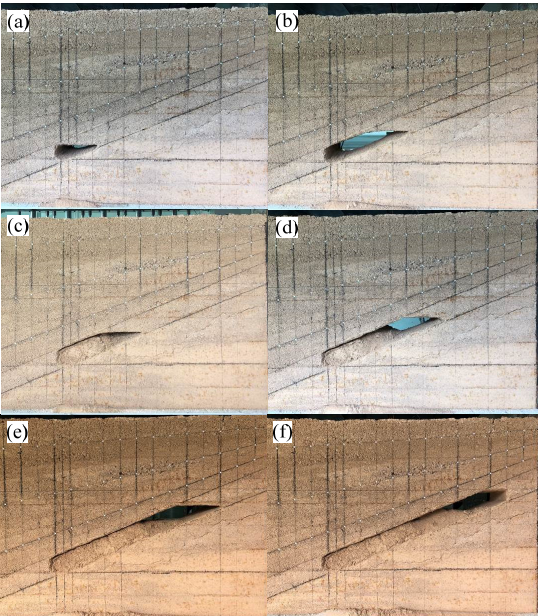
Figure 3. Mining and filling process of similar simulation experiment: ( a ) The first sublevel mining; ( b ) The second sublevel mining; ( c ) The second sublevel filling; ( d ) The third sublevel mining; ( e ) The fourth sublevel mining; ( f ) The fifth sublevel mining.